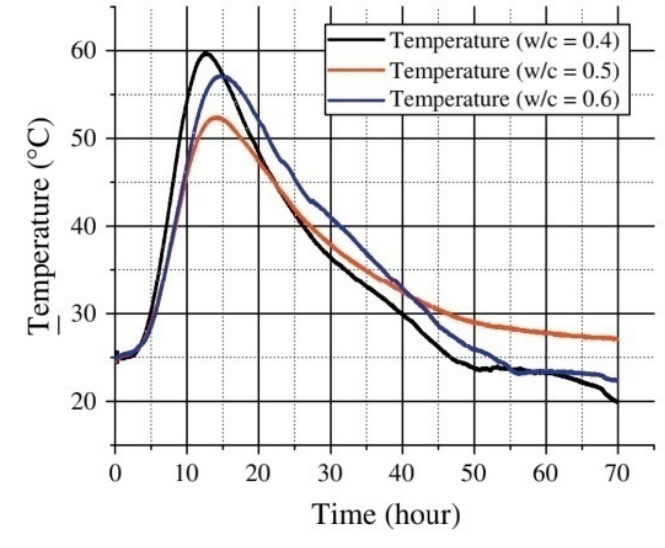
Figure 4. Concrete hydration experiment with water versus cement ratio 0.4, 0.5, and 0.6 using the thermocouple [65].